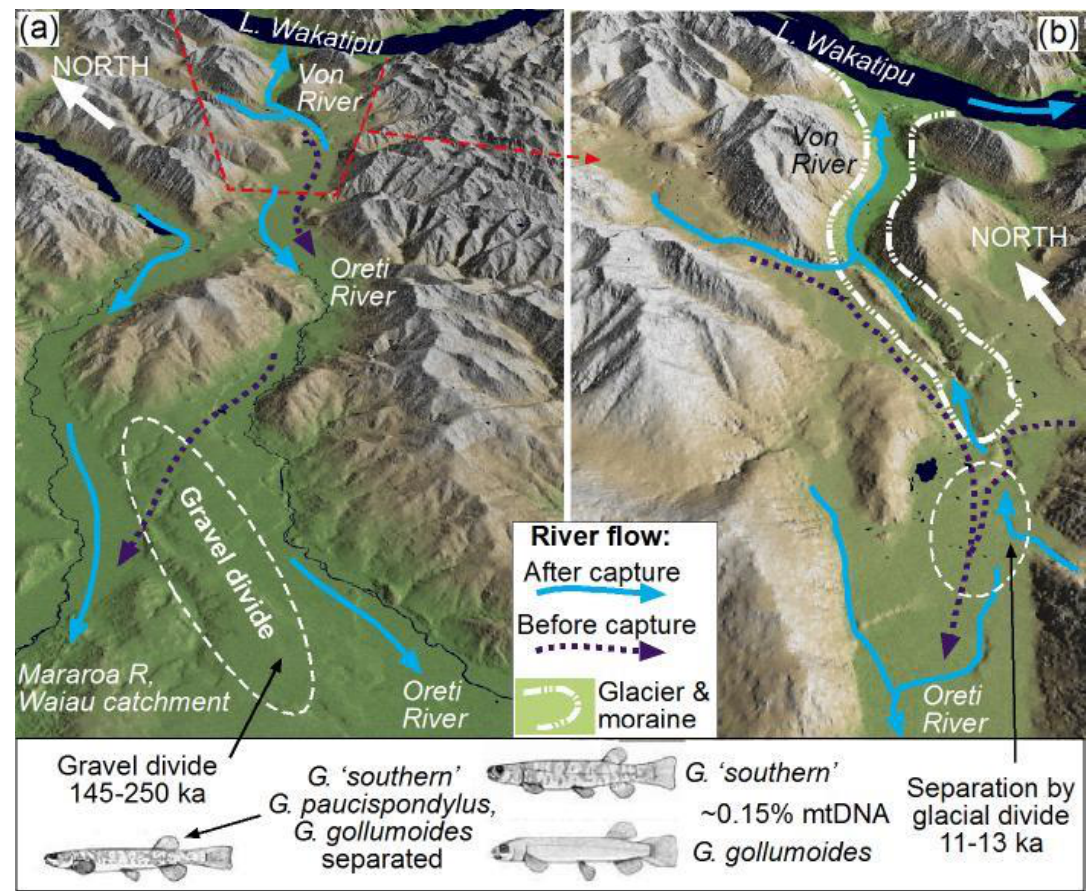
Figure 8. ( a ) Late Pleistocene glacial outwash formed a gravel divide between two major rivers in Western Southland, separating populations of three galaxiid species. ( b ) River re-orientation at the head of the Oreti River (Figure 1) was driven by glaciation extending up the Von valley from Lake Wakatipu. Subsequent early Holocene glacial retreat separated populations of Galaxias ‘southern’ and Galaxias gollumoides into Oreti and Von Rivers.